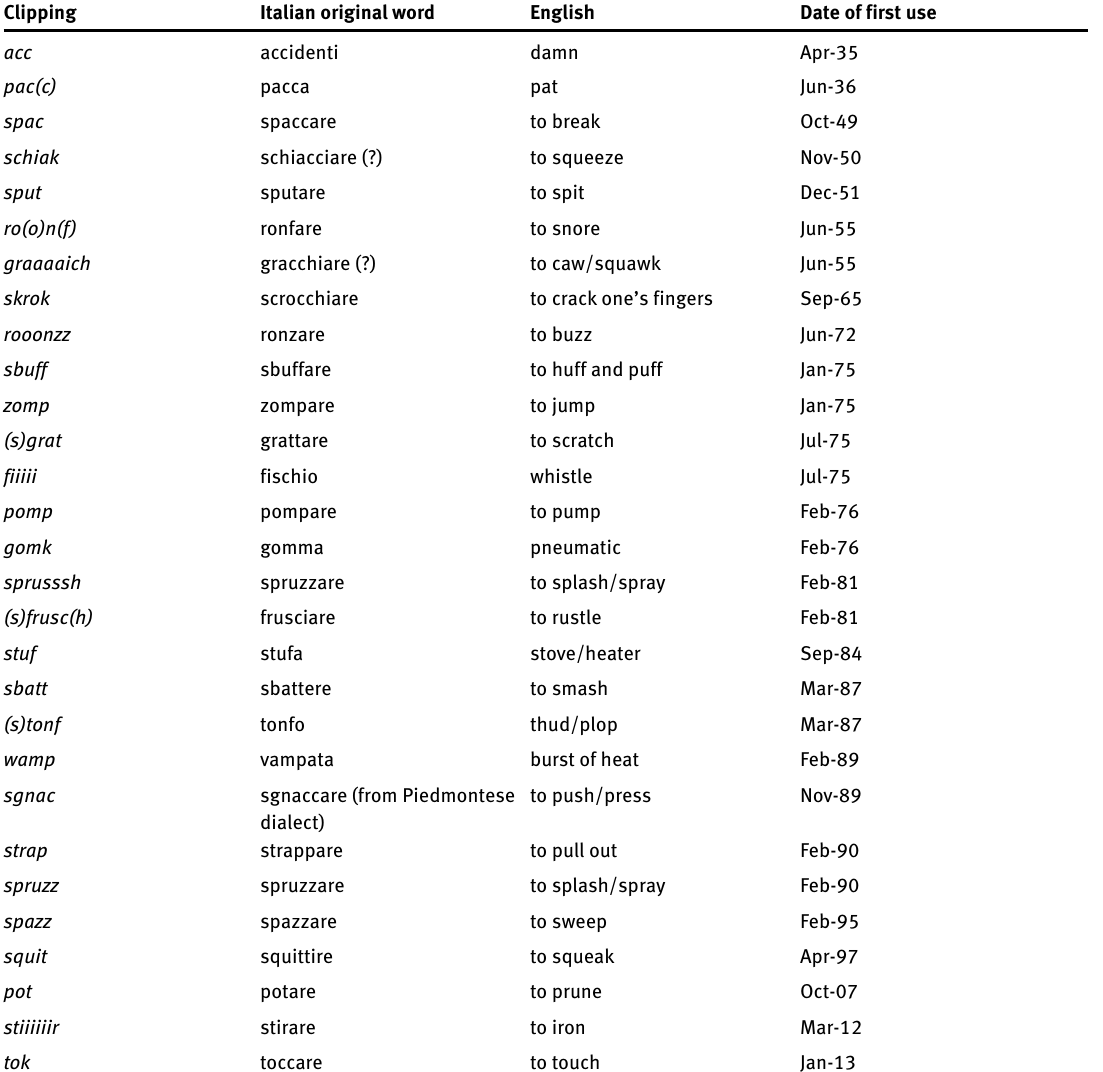
Table 8. Examples of clippings in chronological